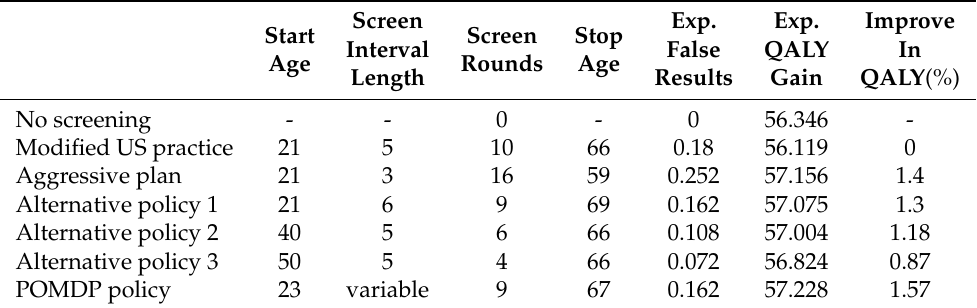
Table 3. Comparison of performance across different policies for a 21 year old patient with no test